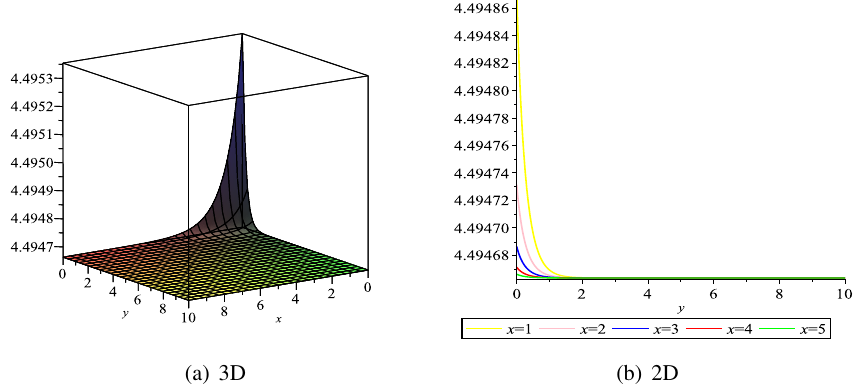
Fig. 3 The singular soliton solution (49) for k 1 = 0 . 5 , k 2 = 1 . 5 , k 3 = 0 . 3 , c 2 = 1 . 3 , δ = − 1 , α = 0 .